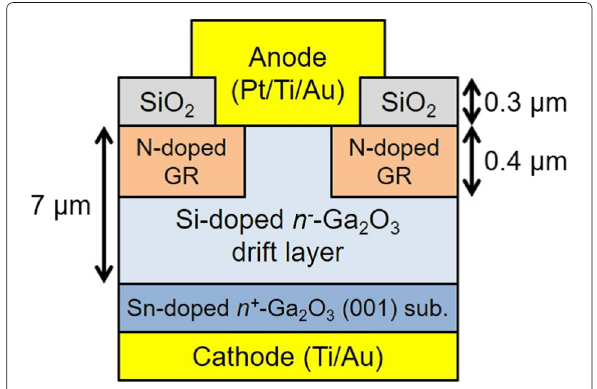
Fig. 8 Schematic cross section of Ga 2 O 3 SBD with field plate and N-implanted guard ring. Adapted with permission [81]. Copyright 2019, IEEE